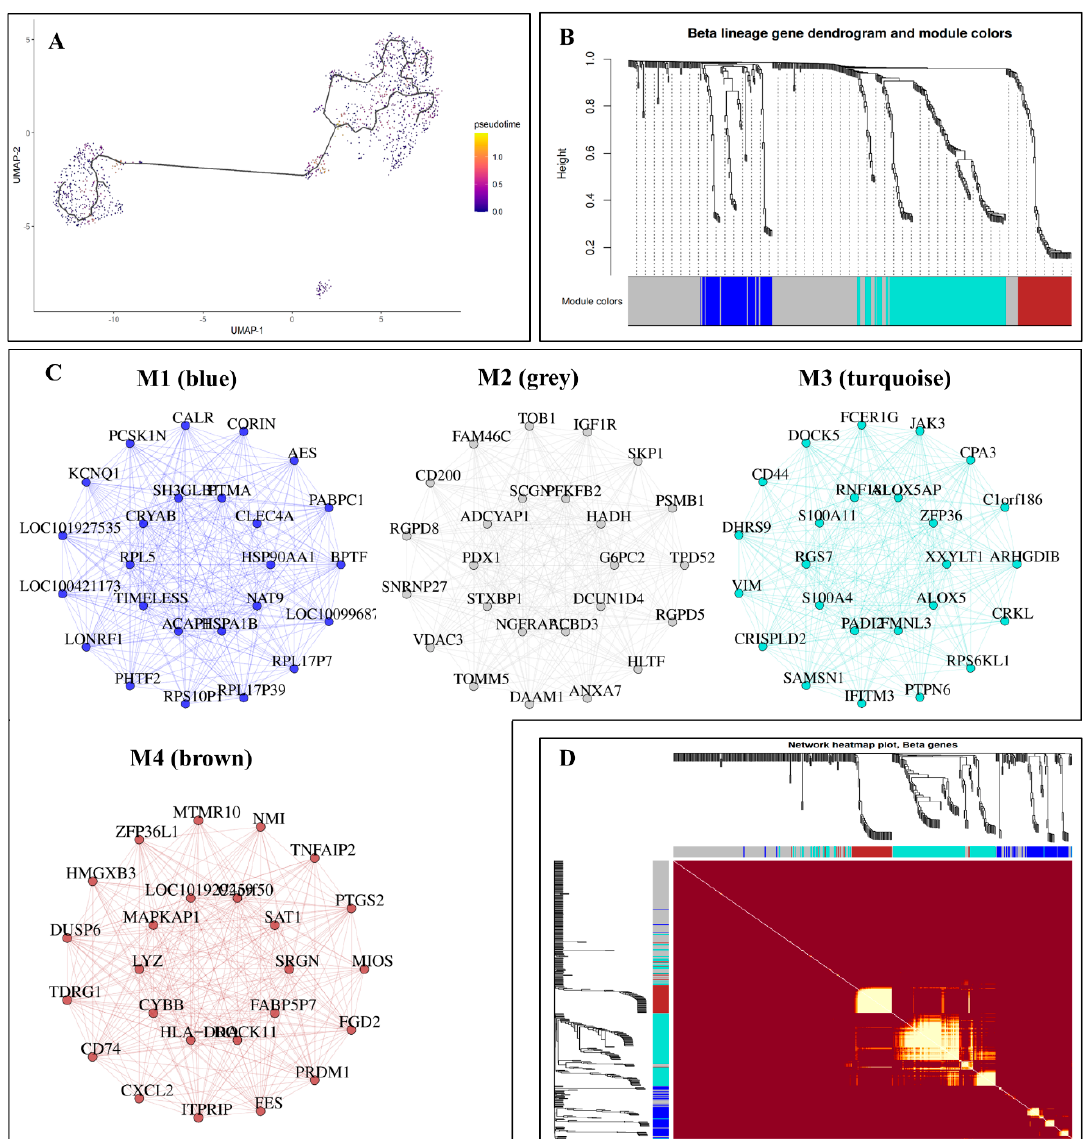
Figure 5. Coexpression analysis in scGENA. ( A ) Pseudotime trajectory of the cell types; ( B ) Dendro- gram and modules colors clustering for β -cells; ( C ) Gene coexpression networks for the four modules in β -cells (M1, M2, M3, and M4); ( D ) Coexpression network heatmap.